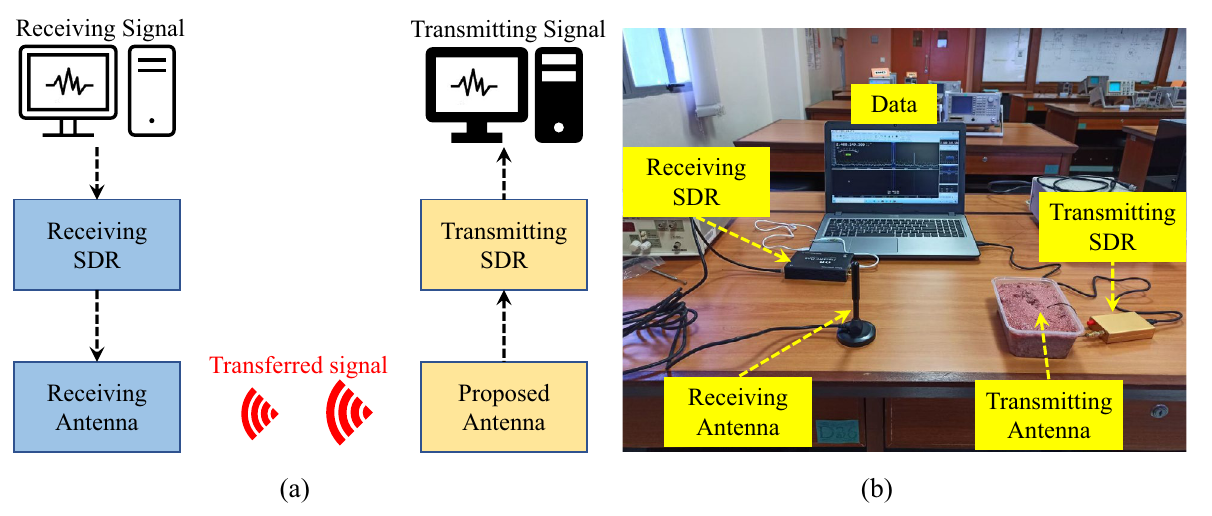
Figure 16. ( a ) Block diagram of experiment. ( b ) Experimental setup for practical measurement of the proposed